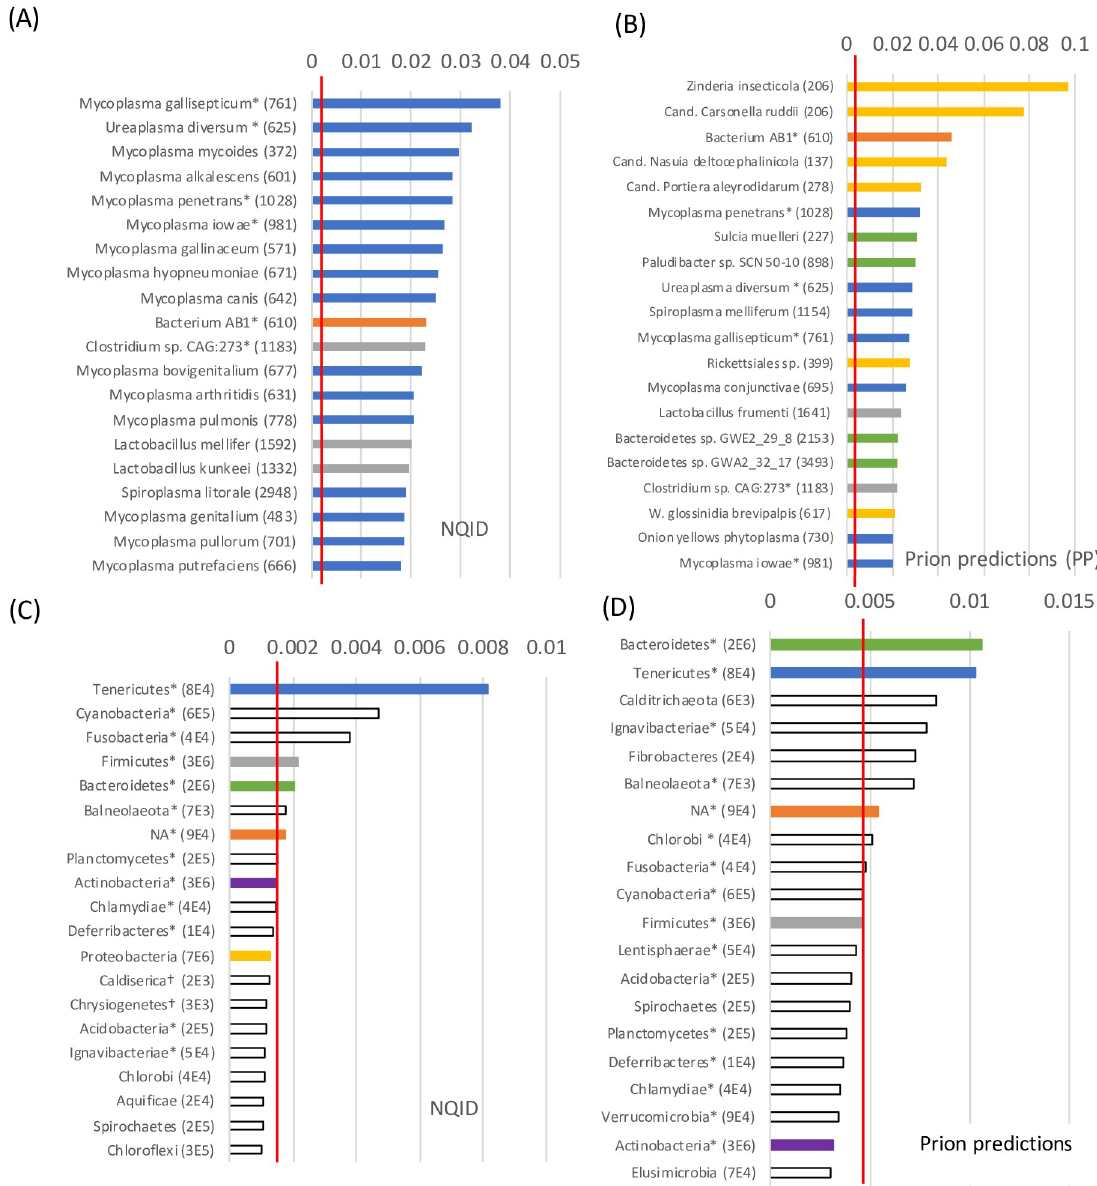
Fig 3. The phyla and species with the highest fractions of prion-like proteins. In (A) and (C), the twenty species and phyla with the highest fractions of prion-like proteins (NQID set) are shown. In (B) and (D), similarly are shown the corresponding lists for the PP set. Parts (C) and (D) also act as color keys for the phyla of the species listed in parts (A) and (B). ‘NA’ means un-classified in any phylum. The total numbers of prion-like proteins of either set are given in brackets after the species or phylum name. Species/phyla that are in both top twenty lists are asterisked. The average fraction of prion-like proteins in either data set is indicated by the red line in each bar